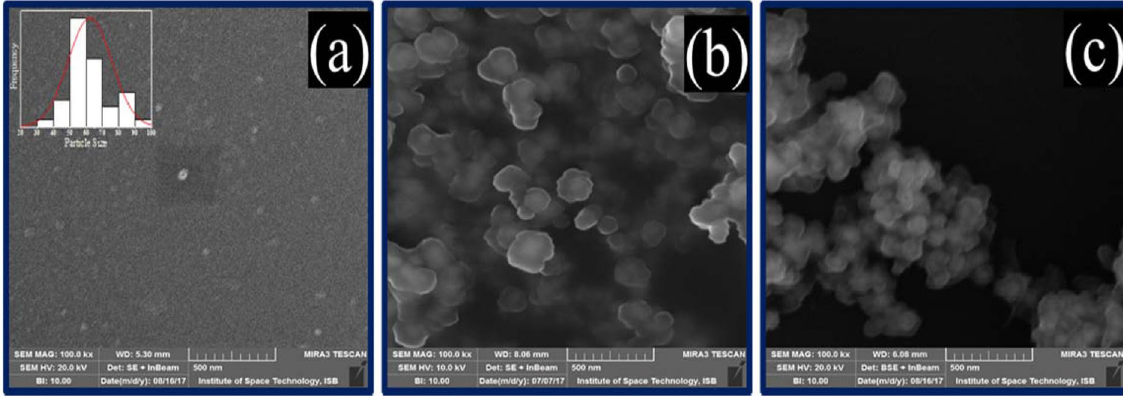
Figure 4. SEM images of ( a ) Fe 3 O 4 , ( b ) silica coated and ( c ) acid functionalized nanoparticles.